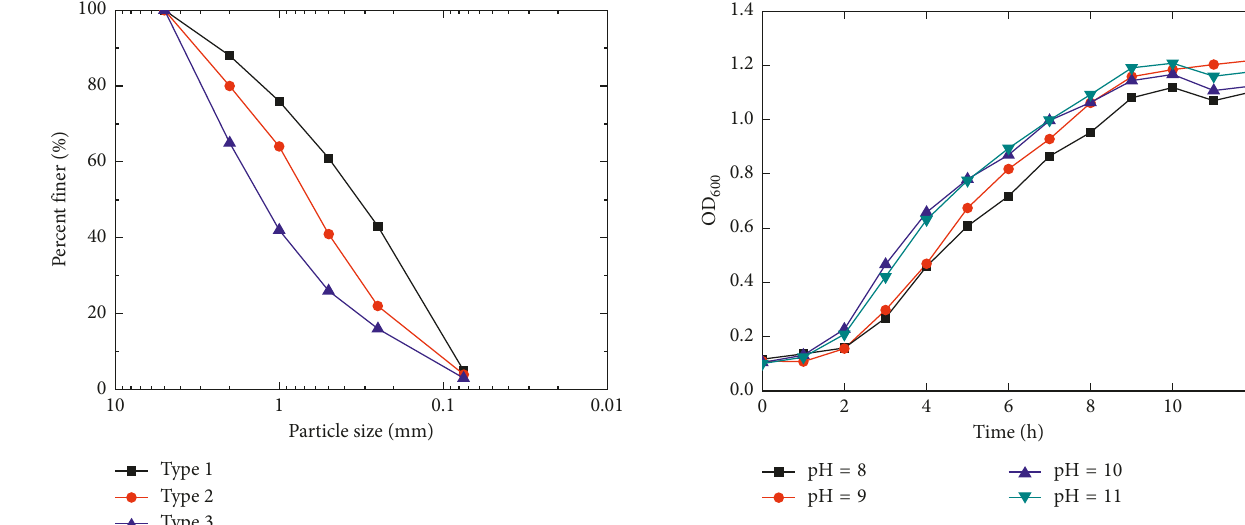
Figure 1: The soil particle distribution curve for 3 types of soil.